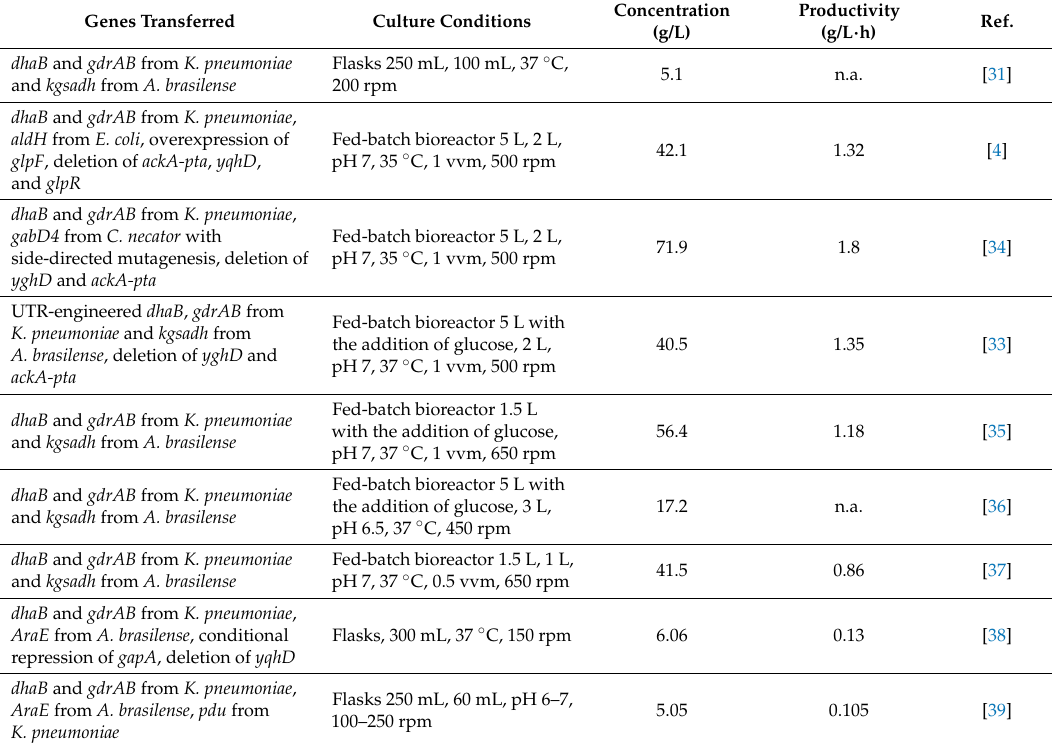
Table 2. Results of 3HP production from glycerol using E.